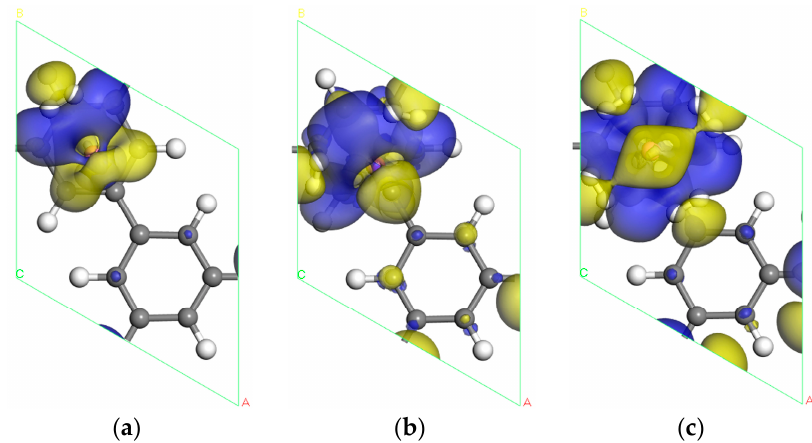
Figure 6. Electronic charge density difference for Sc-decorated PG system in the presence of ( a ) one H 2 molecule; ( b ) two H 2 molecules; ( c ) four H 2 molecules.